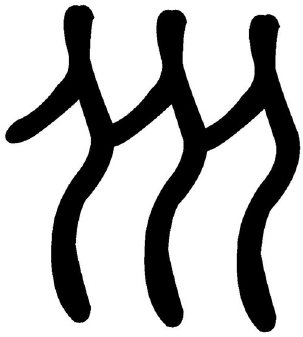
Fig. 7 “ Ren Ren Ren ” trademark of Chun Hui Da Di